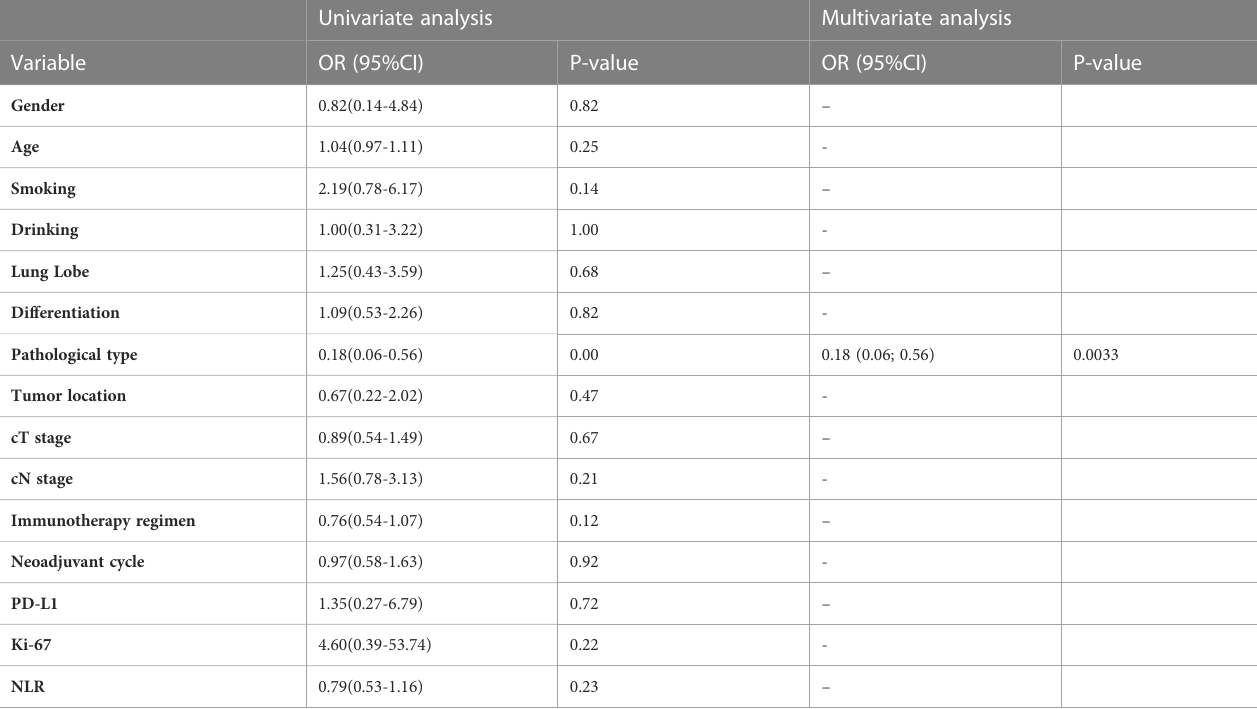
TABLE 2 Univariate and multivariate analysis of clinical data.